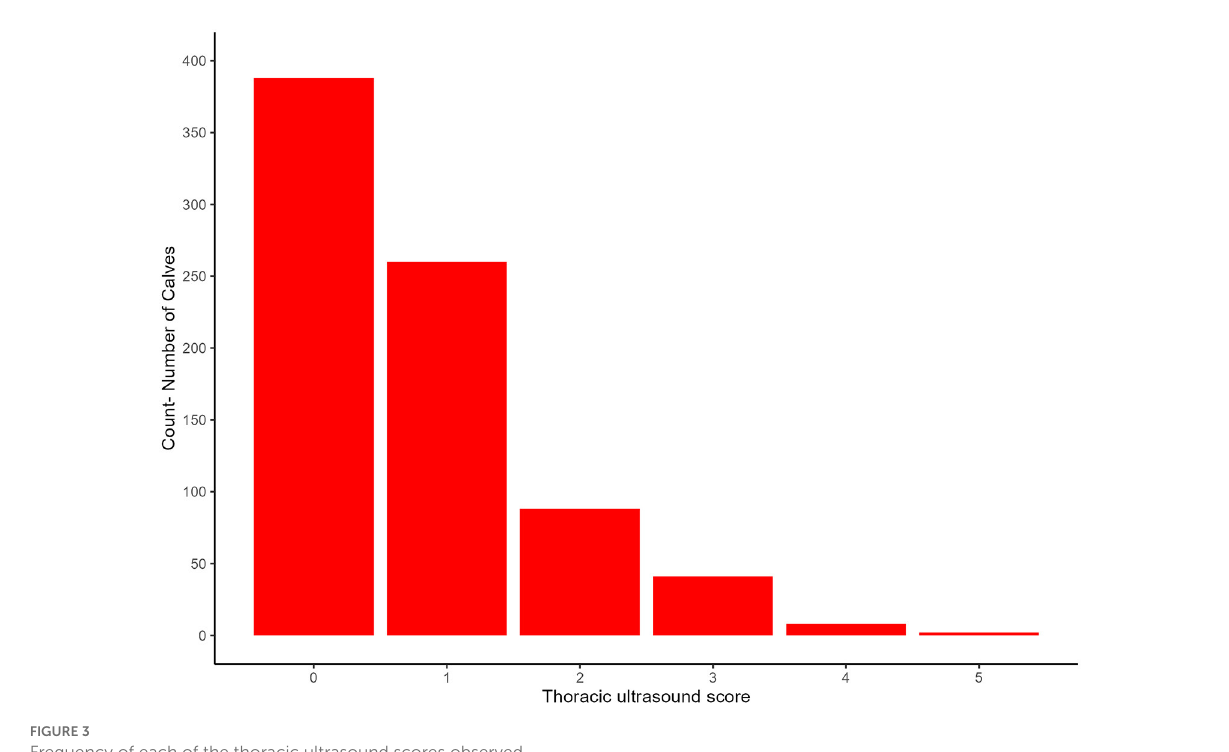
FIGURE3 Frequency of each of the thoracic ultrasound scores observed.